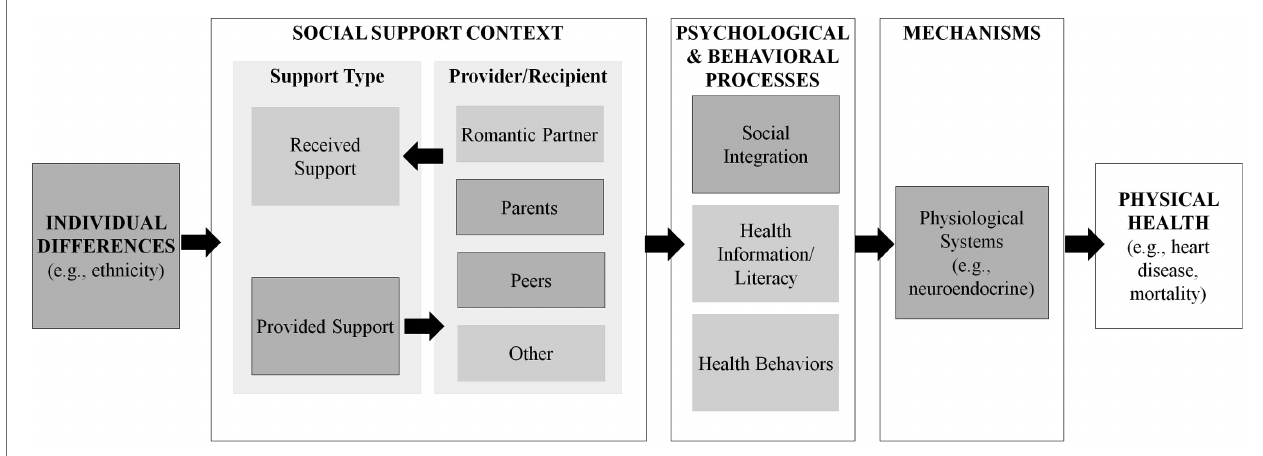
FIGURE 1 | Conceptual model of potential pathways to physical health outcomes. Darkened boxes are constructs examined in the current